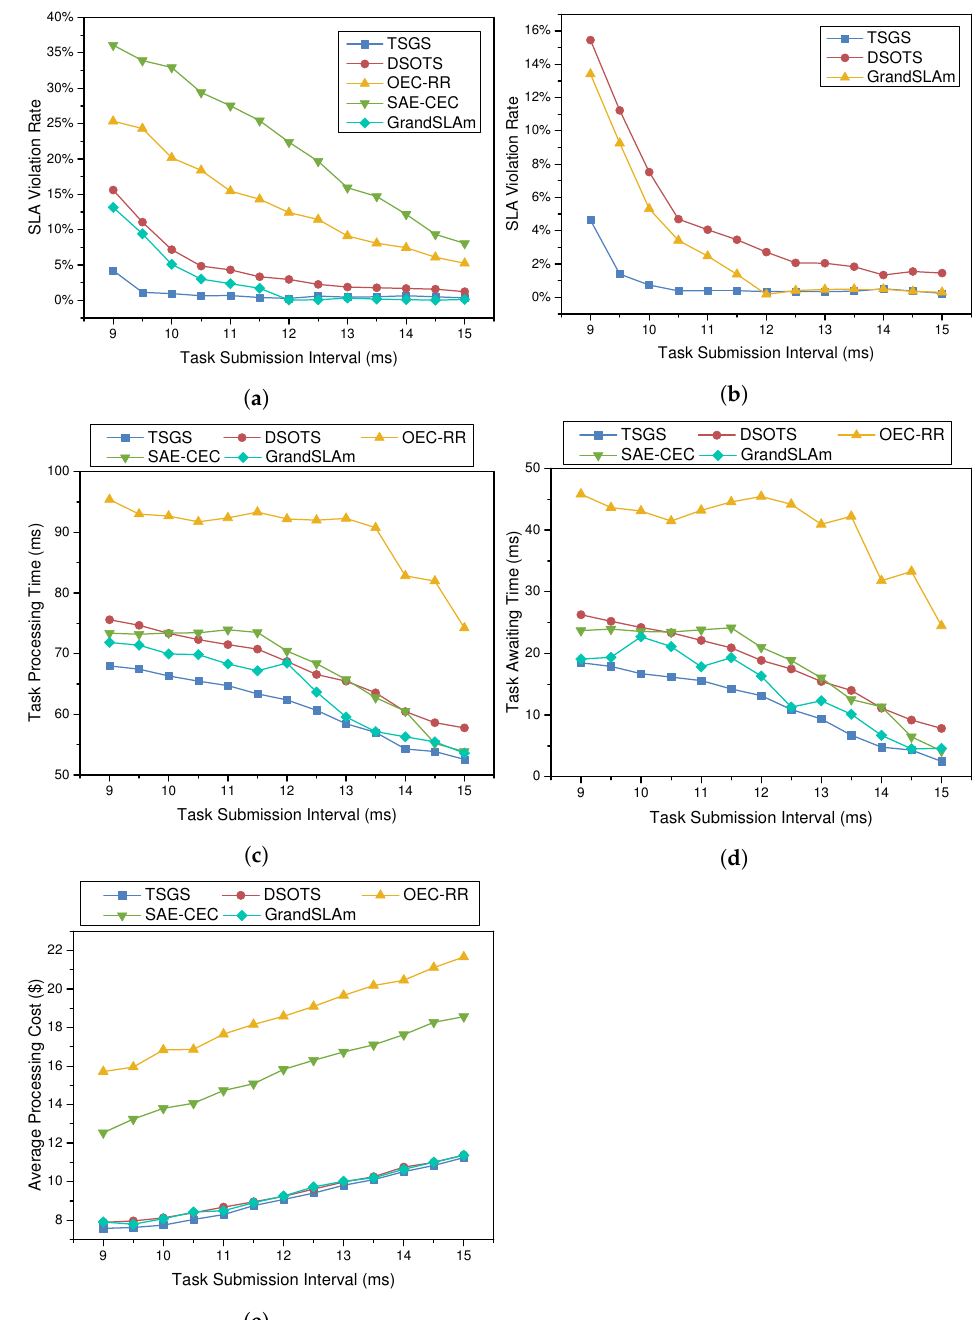
Figure 5. The impact of task submission frequency on SLA violation rate, time, and cost. ( a ) SLA violation rate; ( b ) SLA violation rate (DSOTS vs. TSGS vs. GrandSLAm); ( c ) average processing time; ( d ) average waiting delay; and ( e ) task processing